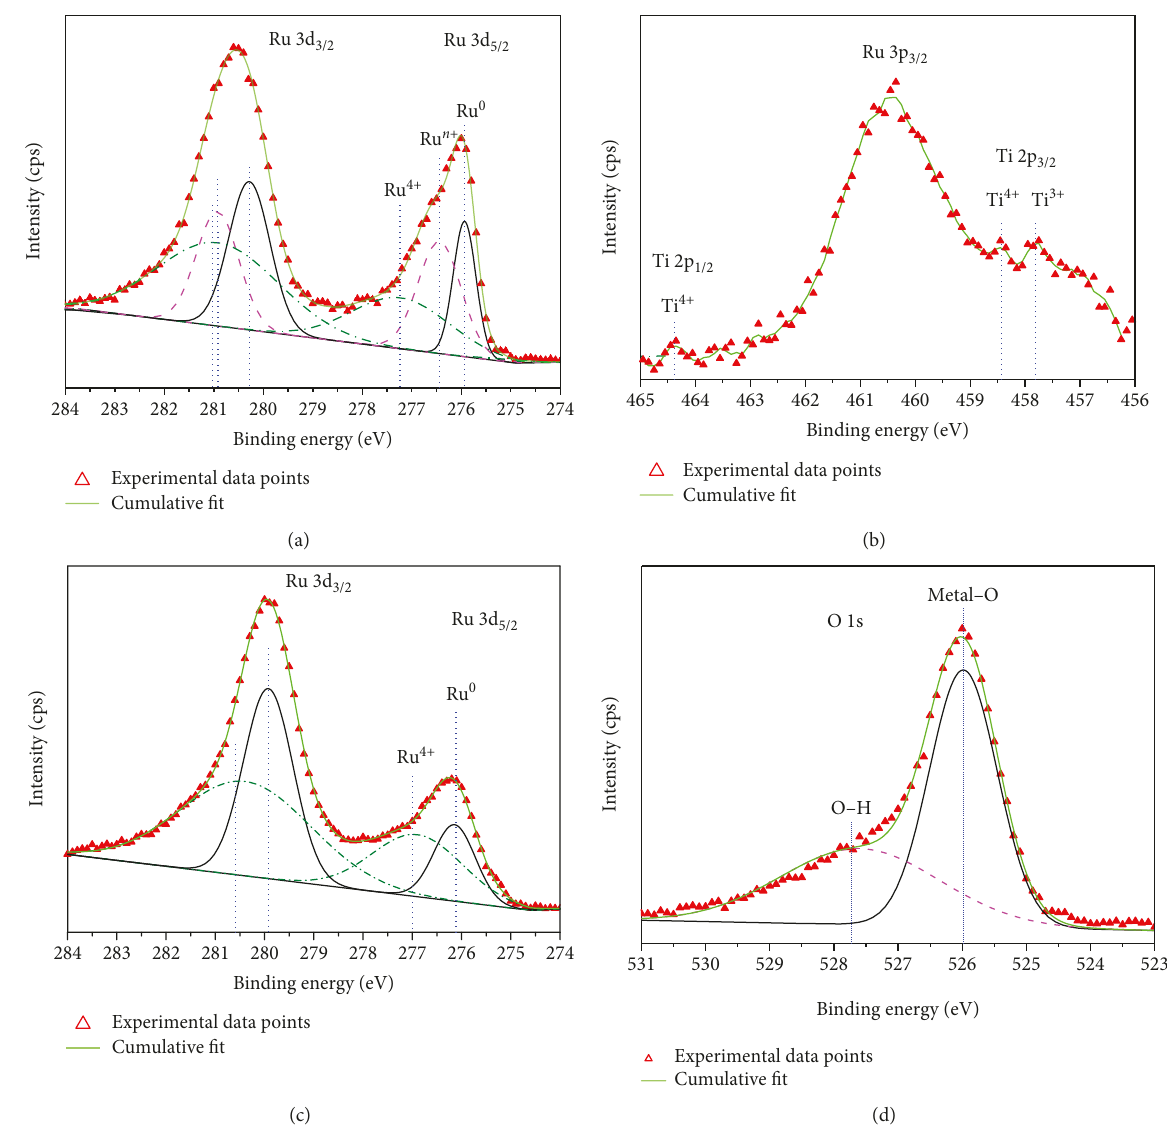
Figure 4: High-resolution XPS core-level spectra of (a) 100%Ru (Ru 3d), (b) 10%TiO /Ru (O (d) 10%TiO 2